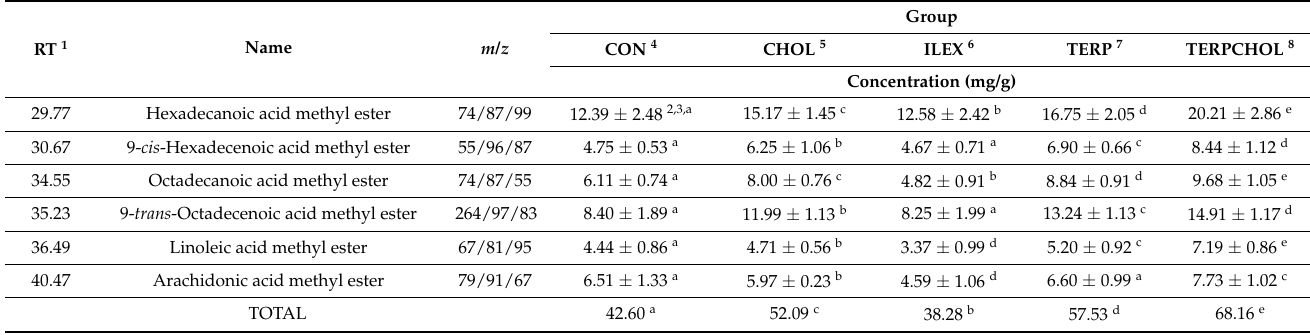
Table 10. Fatty acid profile of liver tissue in normal or hypercholesterolemic Wistar rats after treatment with I. aquifolium and terpenoid